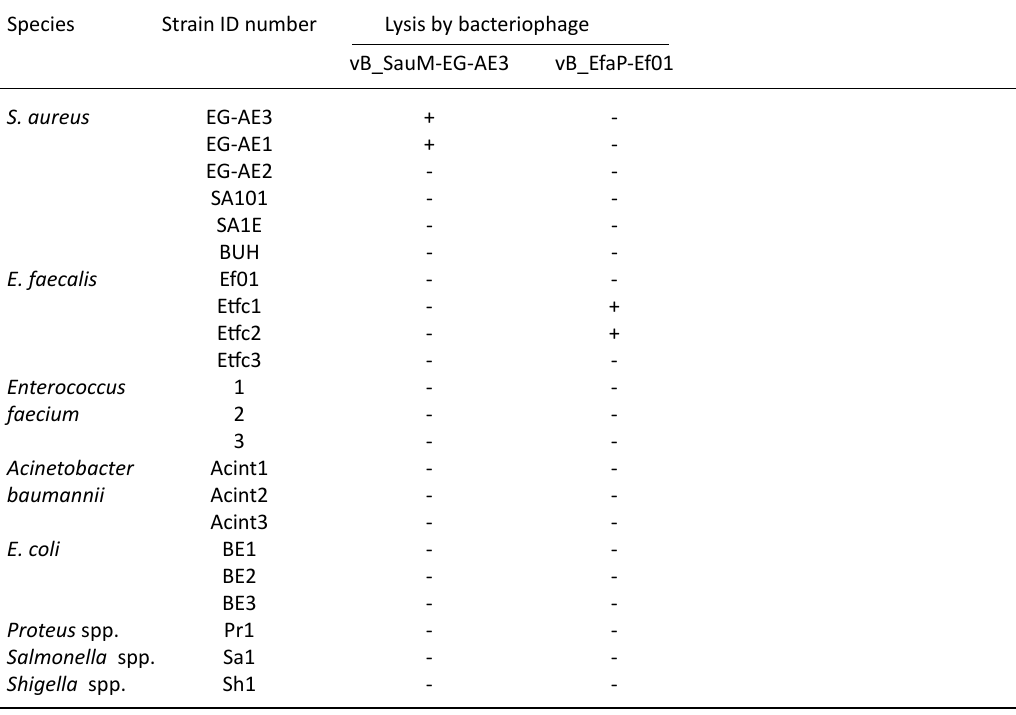
Table 3. Host ranges of the isolated phages Species Strain ID number Lysis by bacteriophage